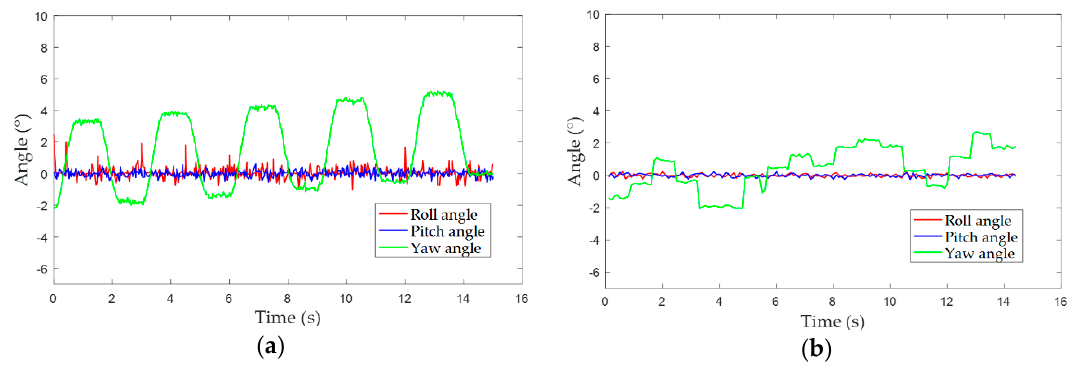
Figure 15. Roll, pitch, yaw angle of WWTG and SSTGL. ( a ) WWTG; ( b ) SSTGL.